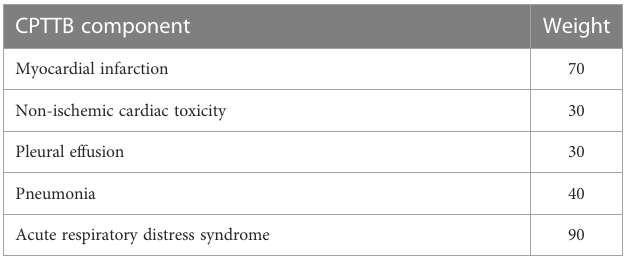
TABLE 2 The components of cardiopulmonary total toxicity burden (CPTTB) are tabulated, along with their corresponding